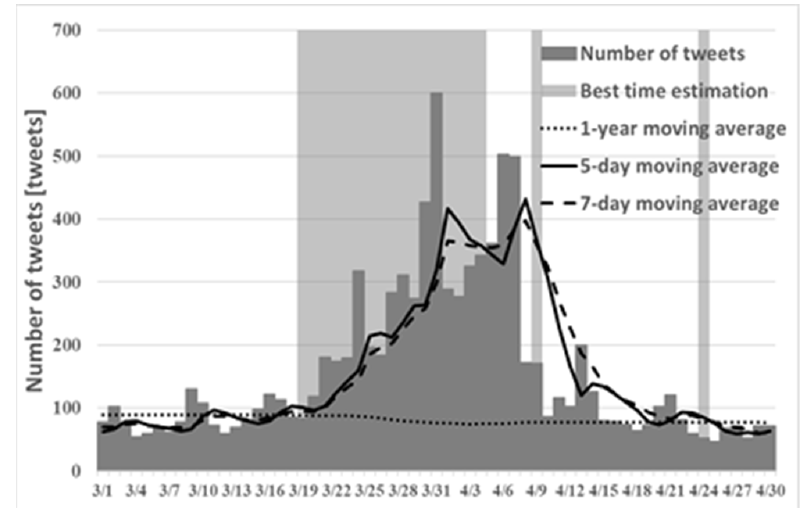
Figure 2. Tokyo in 2019.